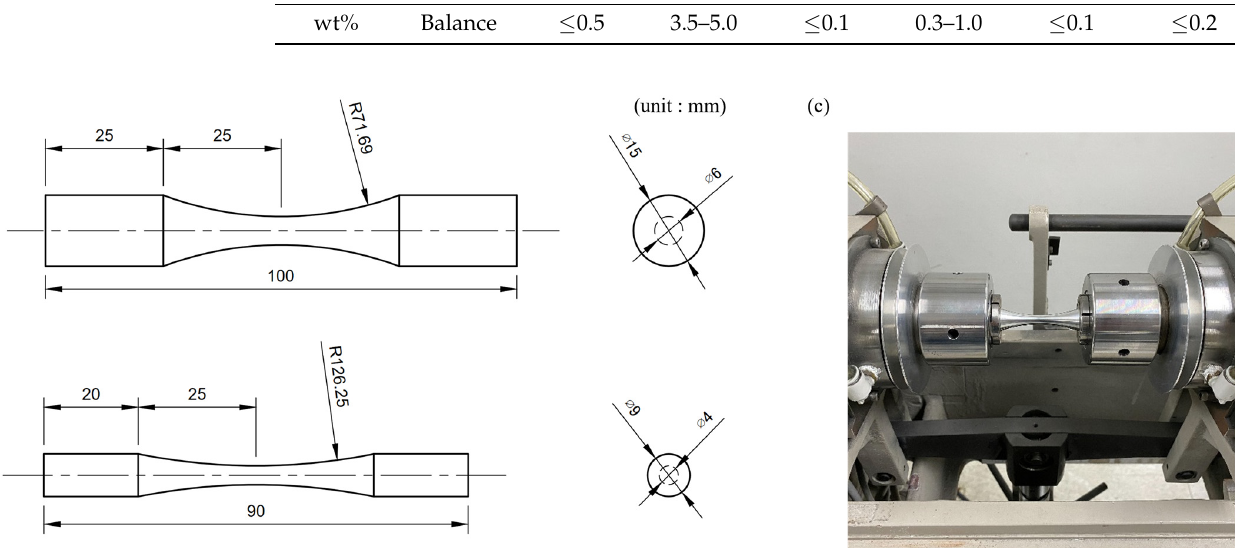
Table 1. The chemical compositions of alloying elements in the Al-F and Al-NF aluminum alloys. Element